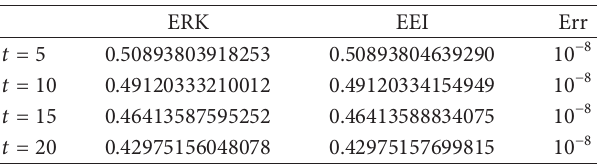
Table 4: The errors of the numerical solutions at different times obtained by ERK method and EEI method. ERK EEI